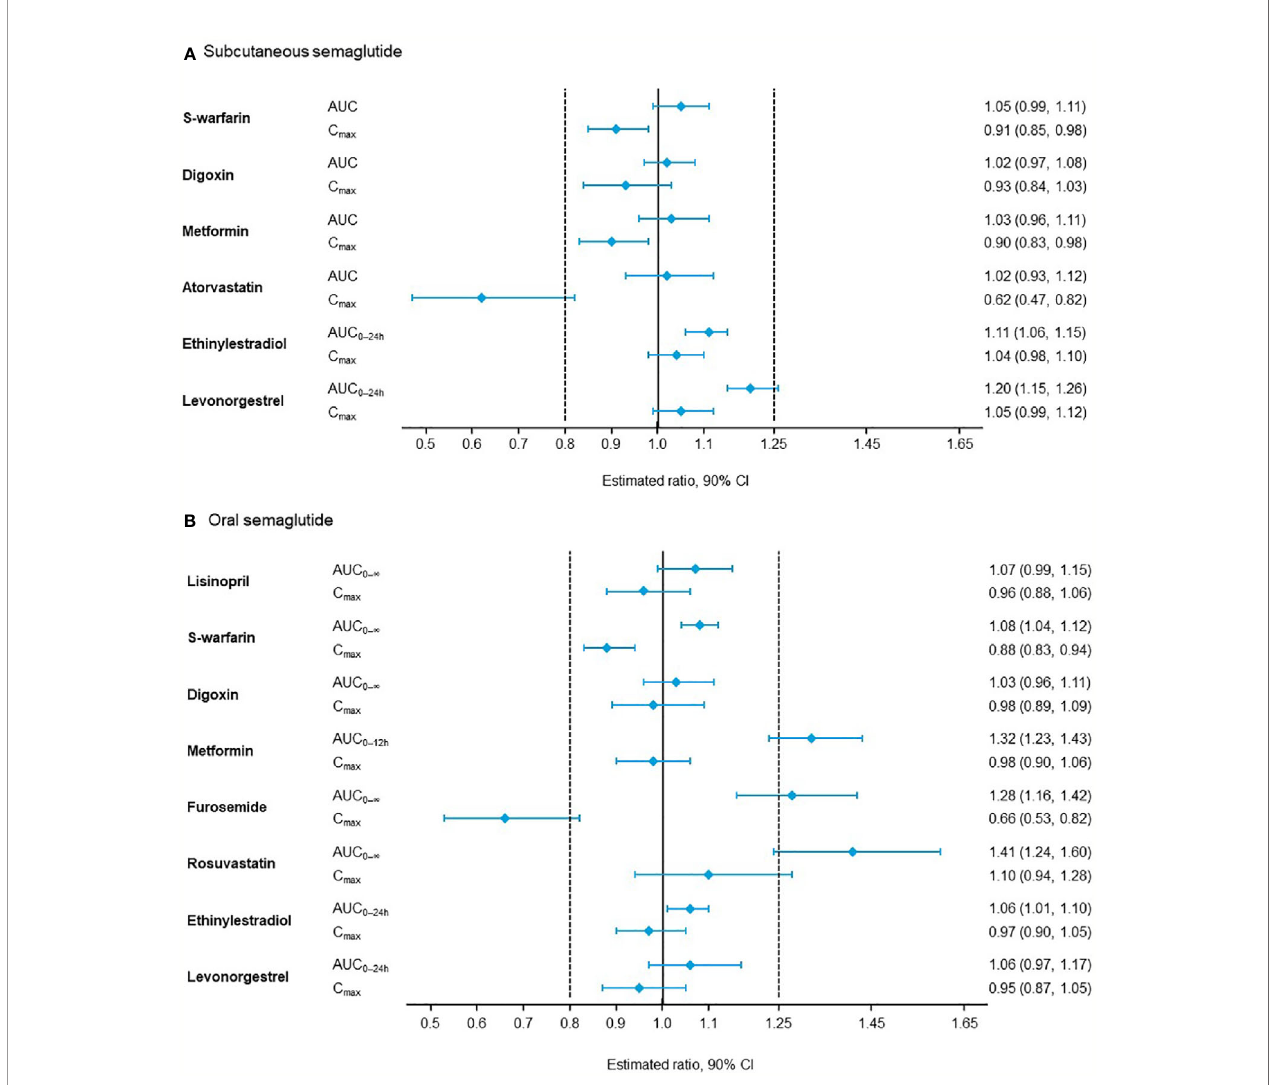
FIGURE 1 | Effect of (A) subcutaneous semaglutide and (B) oral semaglutide on the pharmacokinetics of co-administered drugs (53 – 57). AUC, area under the curve; CI, con fi dence interval; C max , maximum